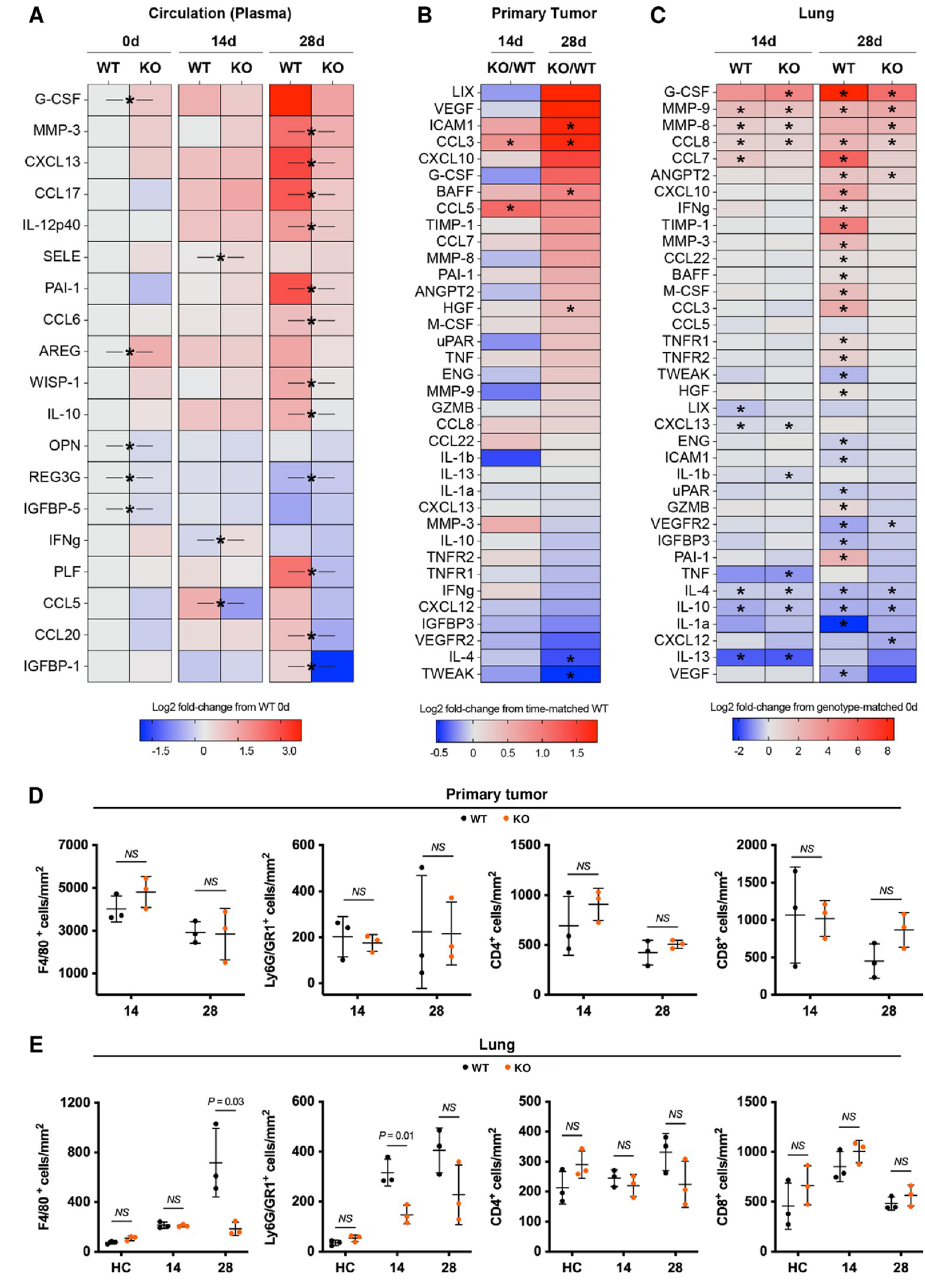
Fig 6. Clic4 host deficiency alters the circulating and resident proteome of primary tumors and lungs. ( A ) Proteome Profiler Array heat map of 19 significantly differentially expressed cytokines and chemokines, from 111 tested, present in plasma from healthy control (0 days) (n = 3) or 6DT1 tumor-bearing Clic4 wildtype (WT) or knockout (KO) mice at 14 days (n = 3) or 28 days (n = 5) after mammary fat pad implantation. Raw values were obtained by determining the pixel intensity for each analyte followed by normalization to the corresponding internal control for each animal. These values were log2-transformed, and the heat map represents the mean log2 fold-change of each group from the WT healthy control group. P values were determined by unpaired t test comparing the raw values of WT and KO at each time point; � P value < 0.05. ( B-C ) Luminex Array heat map of 35 significantly differentially expressed proteins, from 51 tested, present in the primary tumors and lungs of Clic4 wildtype (WT) or knockout (KO) mice at 0 days (lung only, n = 5), 14 days (n = 8), or 28 days (n = 5) after 6DT1 tumor cell implantation in the mammary fat pad. ( B ) Tumor protein expression values shown are log2 fold-change of KO from WT at 14 or 28 days. P values were determined by unpaired t test comparing the raw values of WT and KO at each time point; �